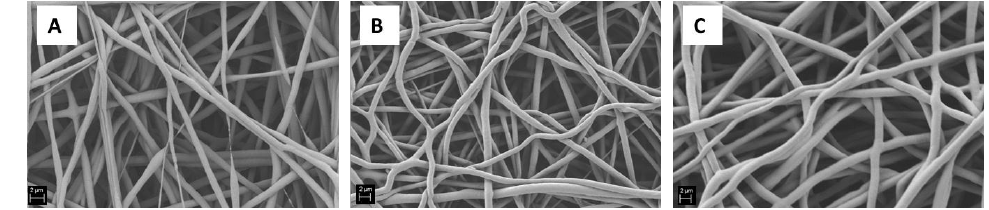
Figure 3. Influence of the applied voltage to the PCL solution of 20% w / v on electrospun fiber characteristics: ( A ) 10 kV; ( B ) 15 kV; and ( C ) 20 kV (scale bar 2 μm).